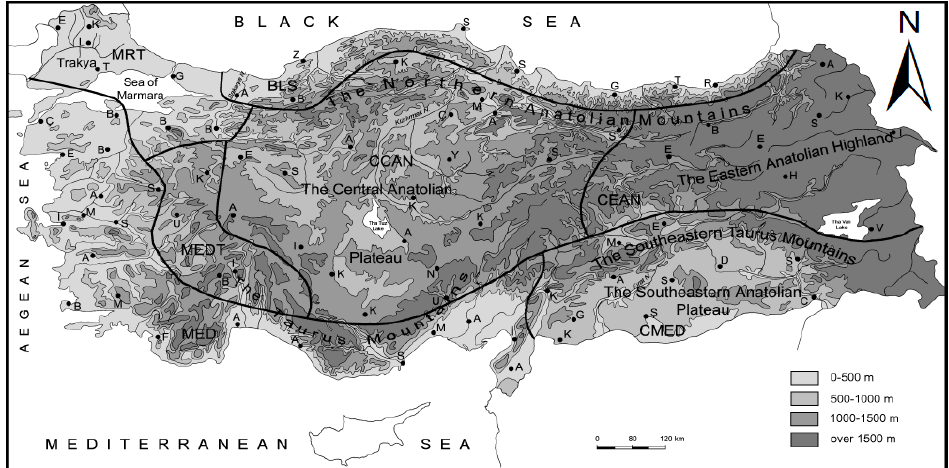
Figure 1. Rainfall regions of Turkey shown over on a physical map. The dots are locations of the meteorology stations, along with first letter of each station name. BLS: Black Sea; MRT: Marmara Transition; MED: Mediterranean; MEDT: Mediterranean Transition; CMED: Continental Mediterranean; CCAN: Continental Central Anatolia; CEAN: Continental Eastern Anatolia [33].